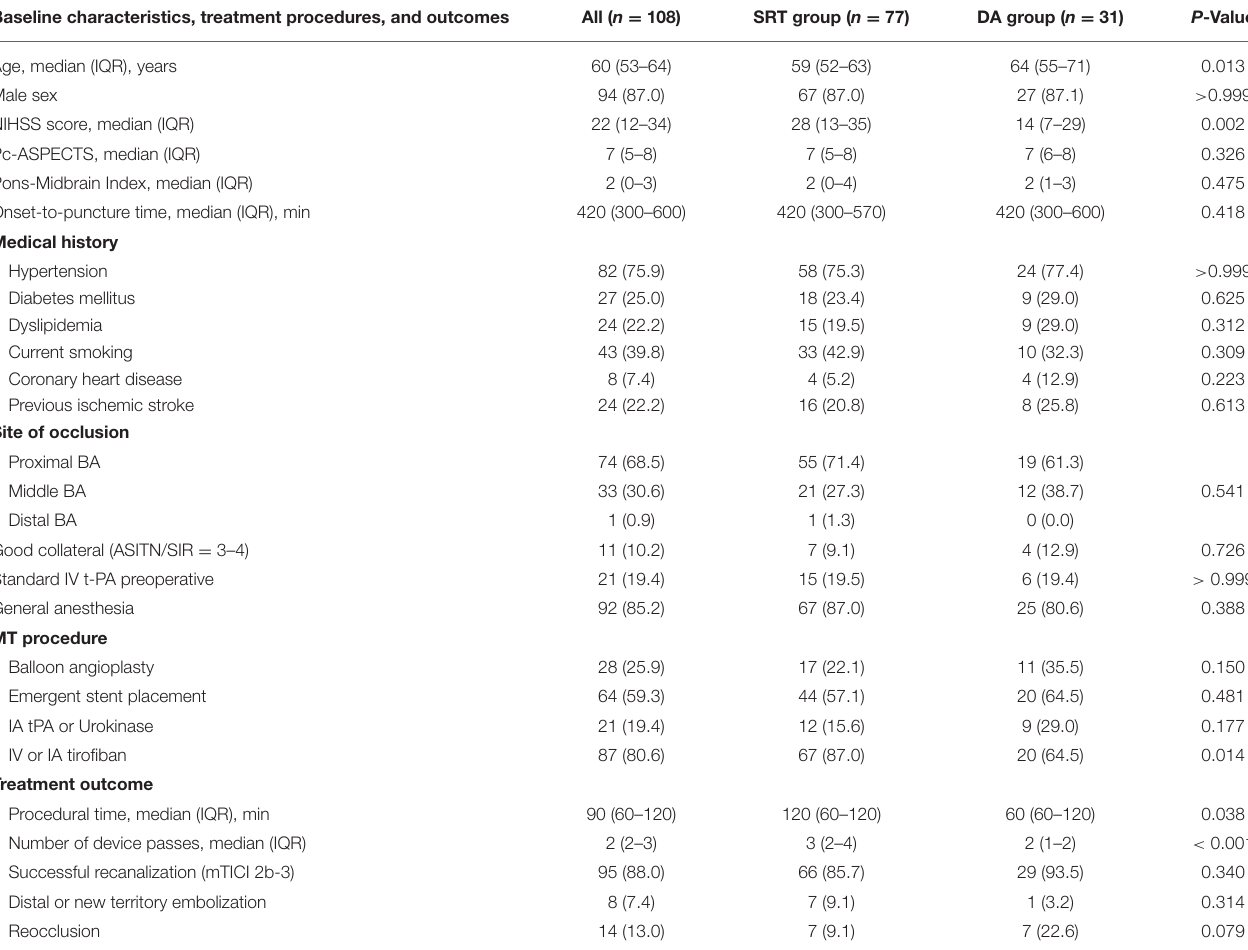
TABLE 1 | Comparison of baseline data and treatment procedure outcomes among SRT and DA groups. Baseline characteristics, treatment procedures, and outcomes